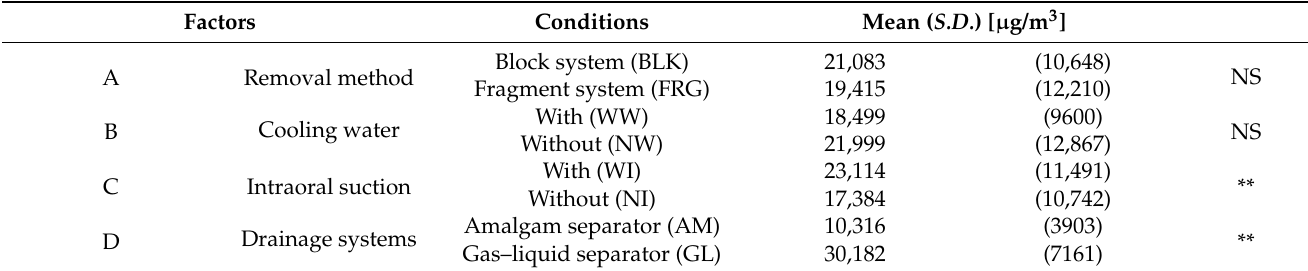
Table 2. The mean values and standard deviations of mercury amount of four-way ANOVA’s main factors in the oral rinse water.